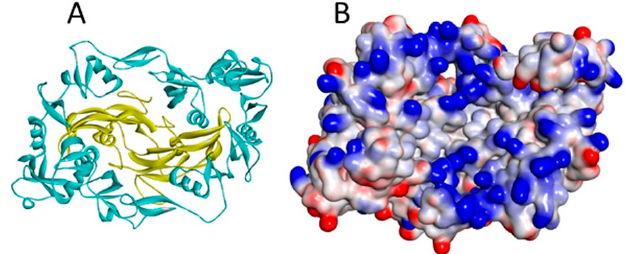
Figure 5. ( A ) The myostatin (yellow ribbon)/follistatin (turquoise ribbon) complex (3HH2.pdb); and ( B ) the same complex shown as a surface coloured according to interpolated charge (positive is blue, negative is red). Though myostatin does not have a heparin binding site, basic residues on its surface are located close to the follistatin binding site in the complex, increasing total affinity for heparin [40].